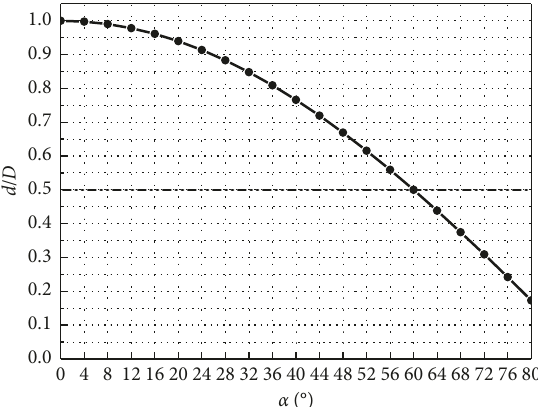
Figure 7: The depth d as a function of the slant angle α